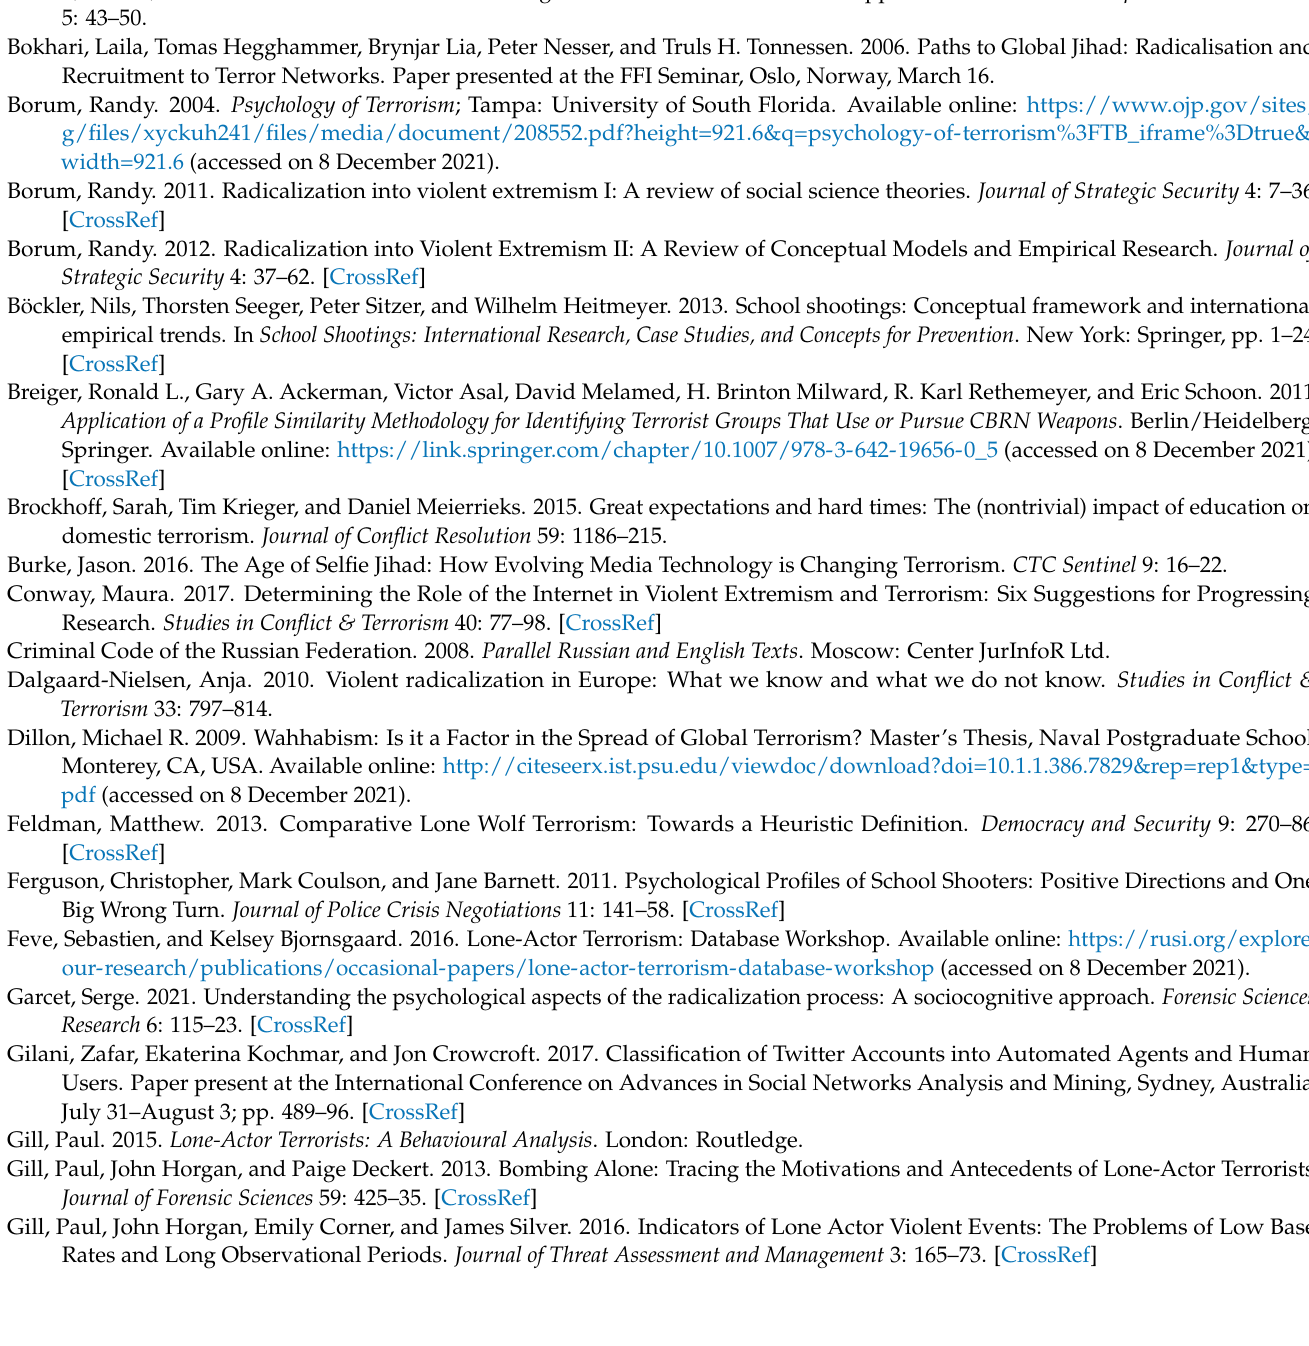
RNU—Russian National Unity. Russian ultra-right nationalist, paramilitary